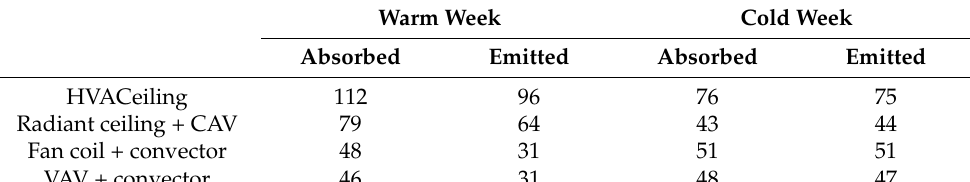
Table 4. Heat emitted or absorbed from the concrete slab in the warm or cold week, in Wh/m 2 .